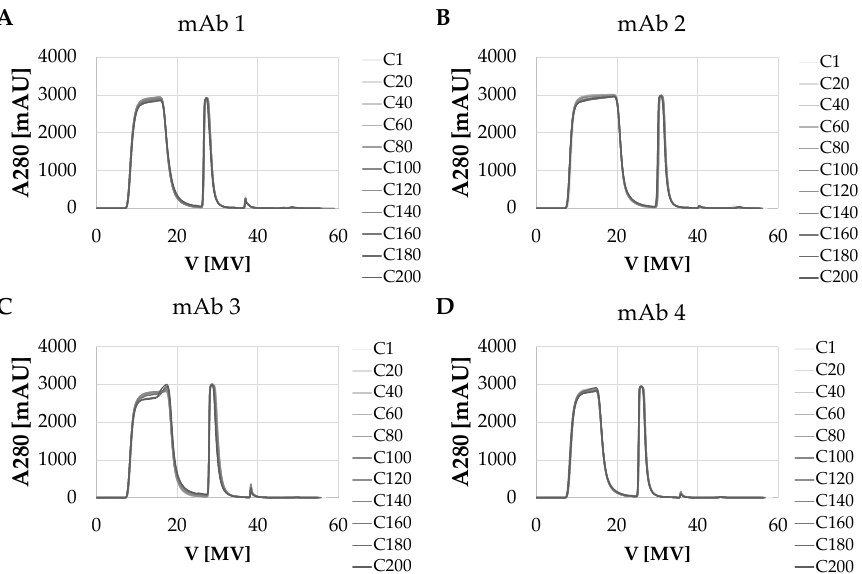
Figure 1. Overlays of UV traces of 200 bind and elute cycles of mAbs 1–4 ( A – D ) using novel convecdiff membrane. Shown is an overlay of every 20th cycle for each experiment. For each of the four mAbs, the intended number of mAb capture cycles was achieved